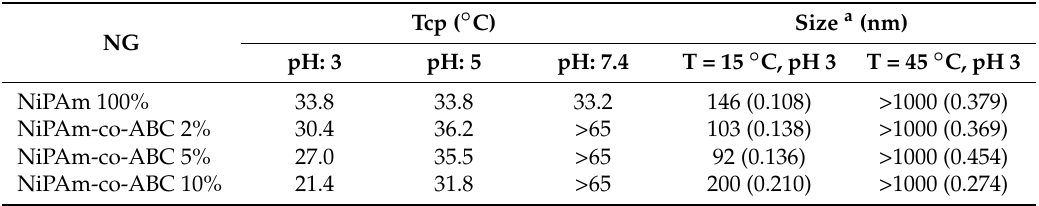
Table 2. Cloud point temperature (Tcp) and diameters in aqueous solutions measured by dynamic light scattering of NiPAm-based nanogel. Adapted from G.N. Rimondino et al. [25].